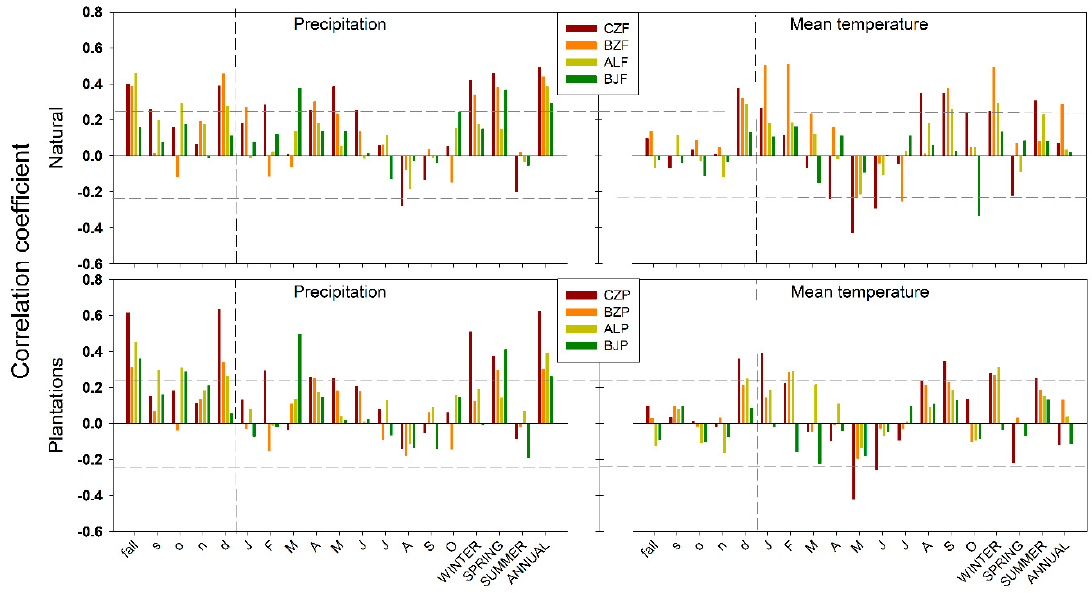
Figure 4. Bootstrapped climate-growth relationships (Pearson correlation coefficients) for the study sites, comparing radial growth (ring-width indices) and monthly and seasonal climatic data (precipitation, mean temperature) for the natural and planted P. pinaster stands. Monthly and seasonal climatic variables from the previous and current year are abbreviated by lower and upper-case letters, respectively. Horizontal dashed lines are significant values ( p < 0.05). The site codes are as in Table 1.